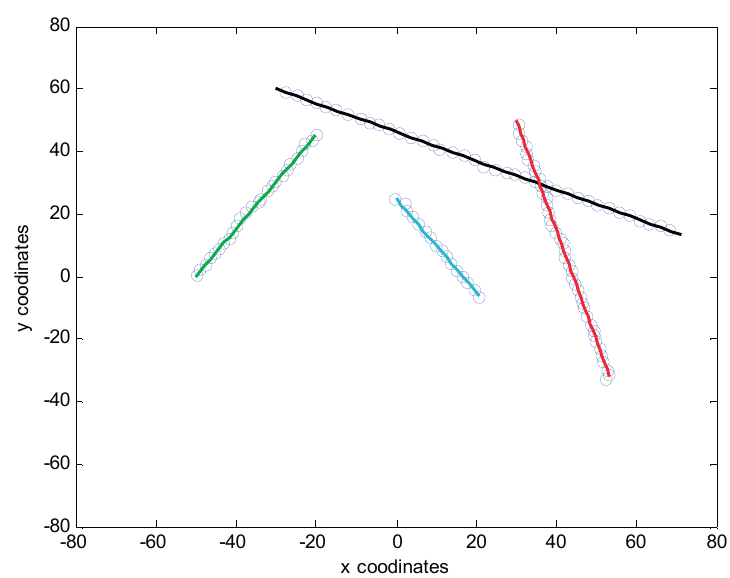
Figure 3. True trajectories and estimates using the proposed algorithm.